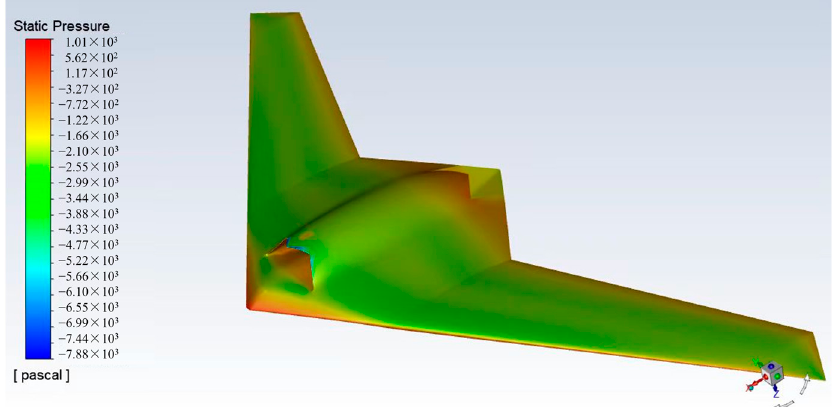
Figure 5. Pressure contour of the aircraft.